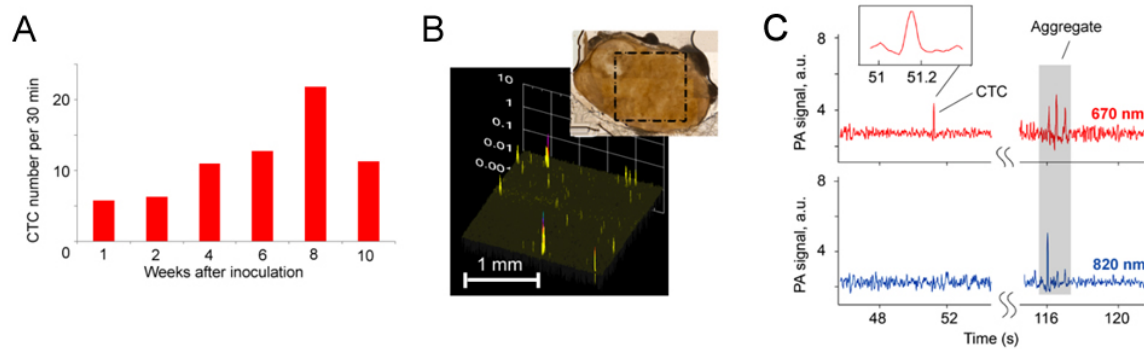
Figure 24. In vivo multifluid PAFC of CTCs in blood, lymph, and CSF systems of breast tumor-bearing mice. ( A ) Dynamics of CTCs in blood circulation during tumor development measured by FFC; ( B ) PA scanning of the SLN; high-amplitude signals color-coded by yellow and red are associated with objects ≤ 15 μ m; ( C ) Two-color (670 nm and 820 nm) PAFC of CSF in vivo through the